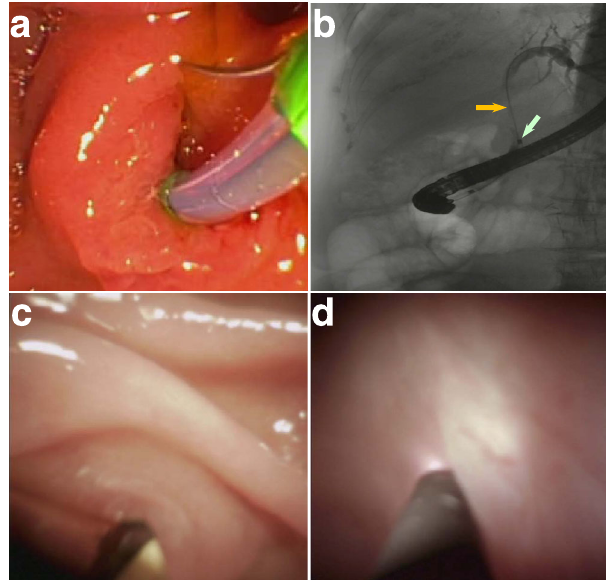
Fig. 2 | Visualization of in vivo LSS-DRS measurements in the bile duct with a cholangioscope or ERCP catheter. a Wire-guided biliary cannulation visualized using a duodenoscope. b X-ray image of the duodenoscope passing the ERCP catheterwithLSS-DRS fi berprobeintothepancreaticobiliarysystem,withtheERCP guidewire (orange arrow)extended to the intrahepaticduct. The radiopaque band atthedistalendofthe ERCPcatheter,markedwithawhitearrow,providesavisual reference for positioning the LSS-DRS fi ber probe. c Cholangioscope entering the pancreaticobiliary system via ampulla of Vater visualized with the duodenoscope. d LSS-DRS fi ber probe, visualized using the cholangioscope, illuminates a location of the internal bile duct epithelial lining and the spectra is